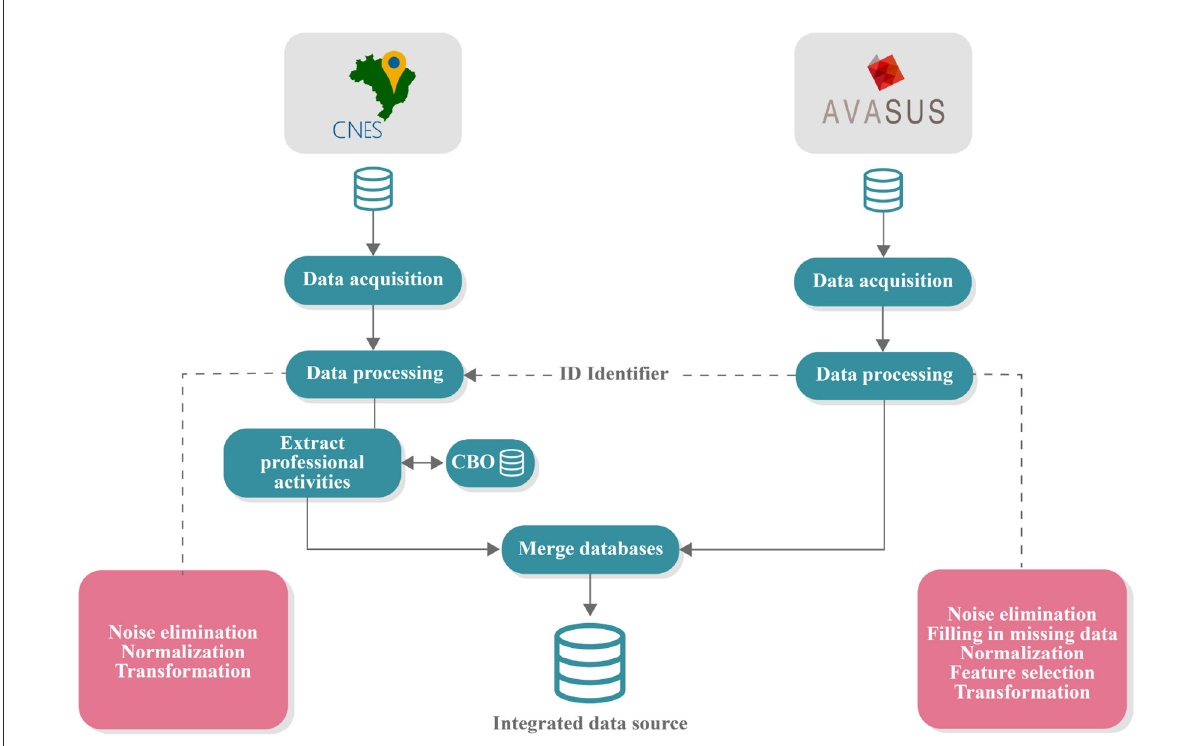
Figure 2 breaks down the pipeline of essential steps for data